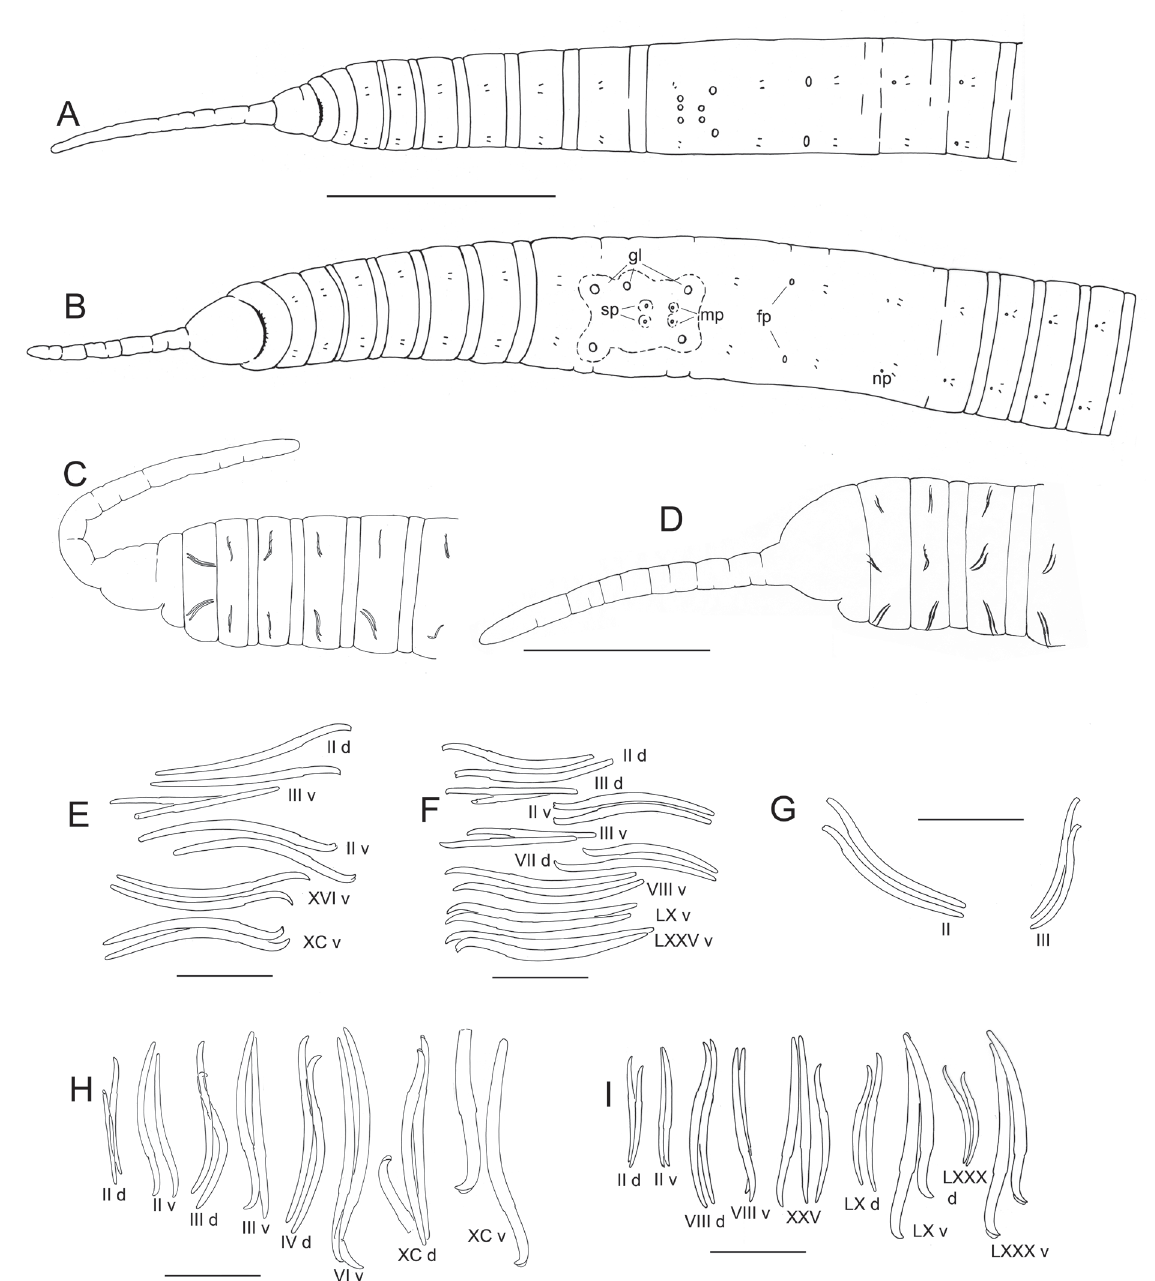
Fig. 7. Guestphalinus exilis Fend & Rodriguez sp. nov., external characters. A–C, E–G from Squaw Creek, CA (the type locality); D, H from South Fork Eel River, CA; I from Stony Creek, CA. A–B . Ventral views of two worms, showing positions of genital pores: A is partially-mature, with 3 glands opening around male and spermathecal pores; B is from a reproductively-mature worm, dashed line encloses the non-clitellar genital field with 5 glands opening around spermathecal and male pores. C–D . Anterior end, showing orientation of chaetae. E–G . Selected chaetae from typical specimens; G shows relative position of dorsal chaetae in II and III. H–I . Selected chaetae from partially-mature worms. Chaetae are numbered by segment (Roman numerals), followed by “d” (dorsal) or “v” (ventral). Scale bars: A–B = 2 mm; C–D = 1 mm; E–I = 100 m